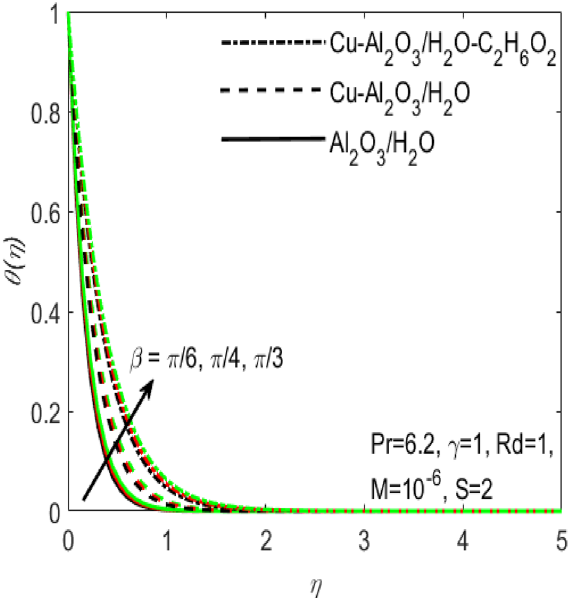
Figure 6. Influence of β on θ(η) for different hybrid nanofluids and simple nanofluid.